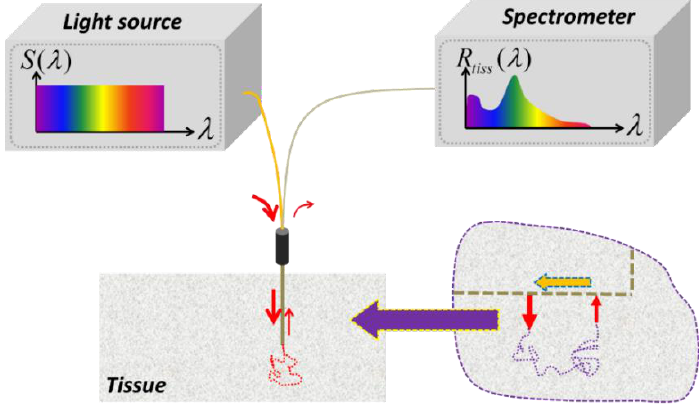
Figure 1. An ideal light source for single-fiber reflectance spectroscopy (SfRS) has a uniform intensity profile across the broad spectrum of interest. With such a light source, what is measured out of the light collected from the single probing fiber represents exclusively the tissue reflectivity as a function of wavelength, with which the optical properties, including absorption and reduced scattering coefficients of localized bulk tissue, may be recovered. The inset enclosed by the dashed circle indicates that the single-fiber configuration can be approximated by a dual-fiber configuration in its limites case or a dual-path configuration: (1) a dual-fiber configuration with separate delivery and collection fibers, by letting the distance between the delivery and collection fibers approaching the size of the fiber; (2) a single-fiber dual-point configuration, wherein the points of light delivery and light collection are different, but both are located at the facet of the fiber tip. Either of these two treatments would facilitate analytical evaluation with the assumption of photon-diffusion